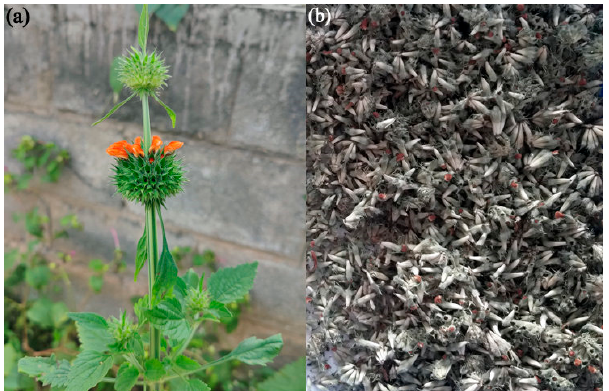
Figure 1. ( a ) Plant of L. nepetifolia with flowering twig, and ( b ) shade-dried flower buds.